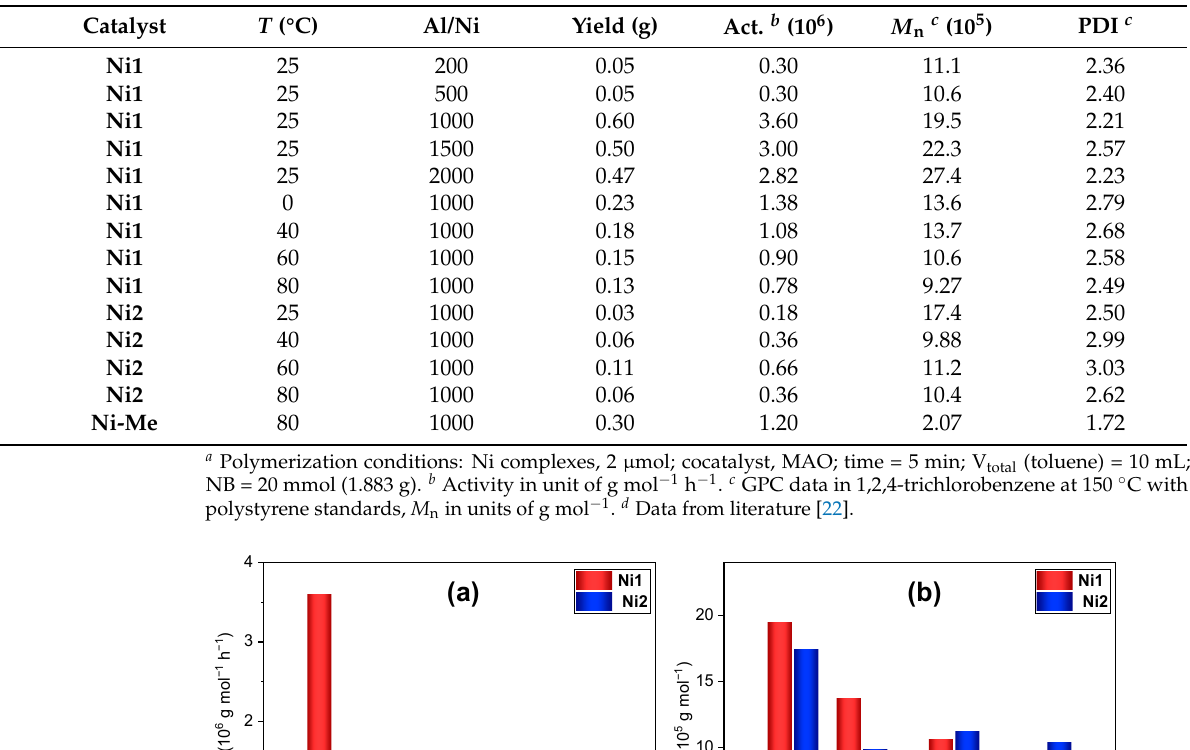
Table 1. Polymerization of norbornene by nickel complexes a .